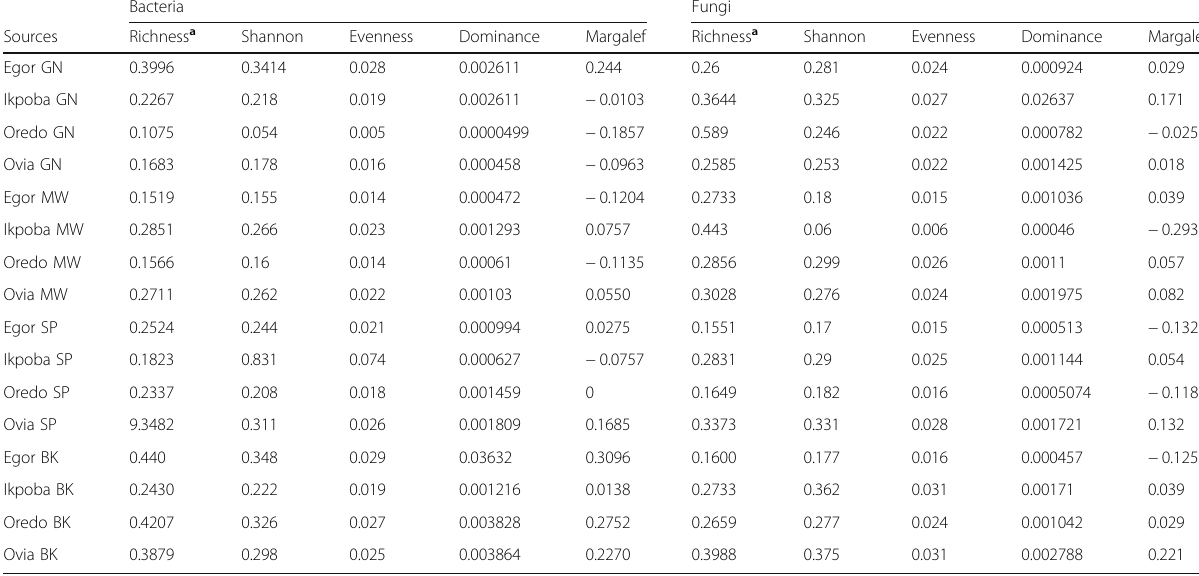
Table 4 Bacterial and fungal diversity, richness, evenness, and dominance indices in the different spent crude oil-polluted soil Bacteria Fungi